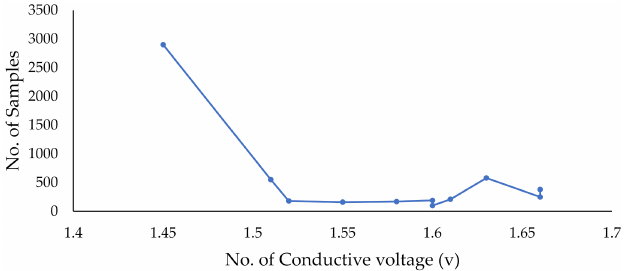
Figure 8. Graph of the third case with two participants.